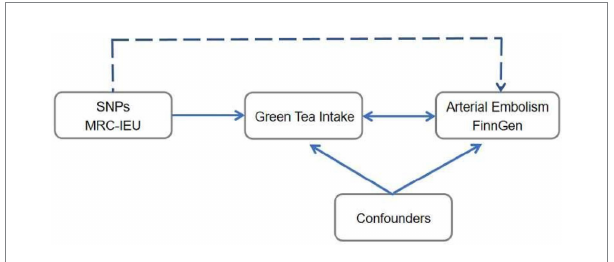
FIGURE 1 Schematic representation of our MR